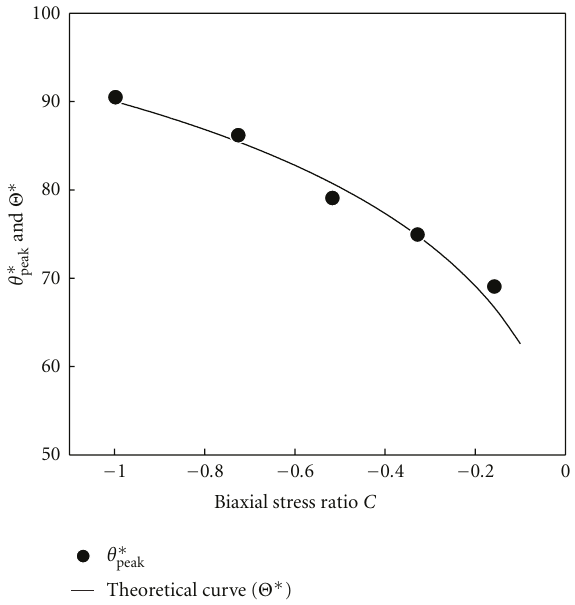
Figure 10: Relationship between θ ∗